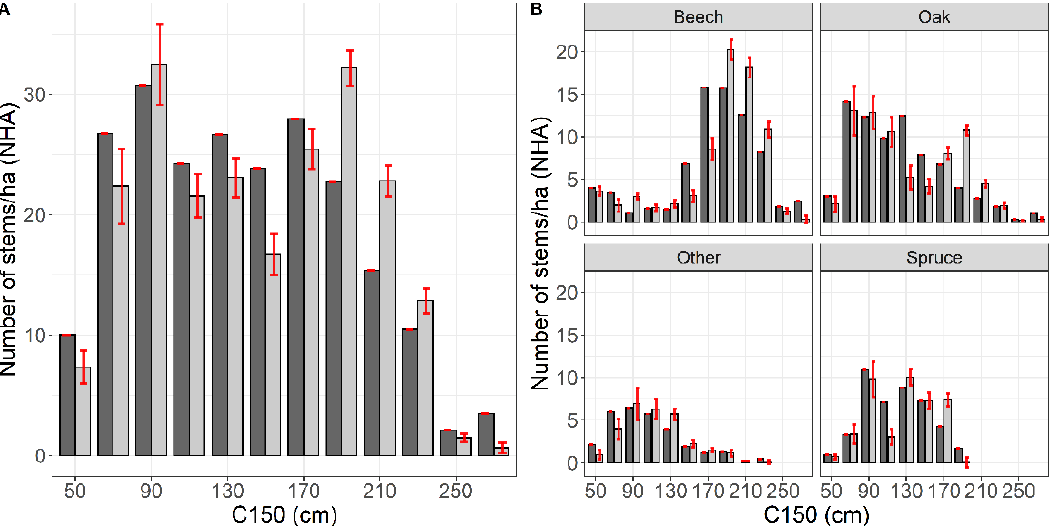
Figure 7. SSDs for the training dataset: ( A ) total SSD per hectare and ( B ) species-specific SSDs per hectare. Dark bars show field measurements and light bars show predictions. Red error bars correspond to residual standard deviation of the stem density calculated from the cross validation results. Table 7. Species-specific SSD accuracies computed by species class for the NN training dataset. Table 6. Confusion matrix for the circumference class (c150) prediction. Class value corresponds to the center of the circumference class (cm).